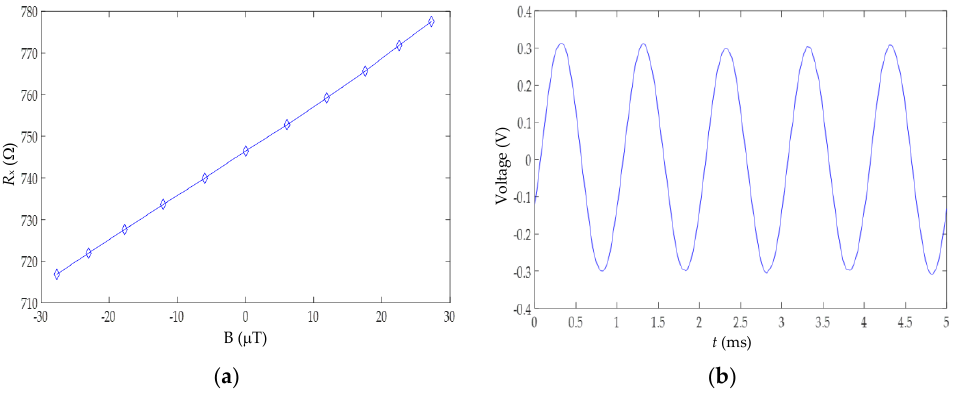
Sensors 2017 , 17 , 1150 Figure 6. ( a ) Transfer curve of the TMR2503; ( b ) Sensor output signal using a classical read-out circuit of the sinusoidal signal have the same measurement result; in other words: the DIC was not able to detect the resistance change between these two samples. For this reason, the “sinusoidal” signal